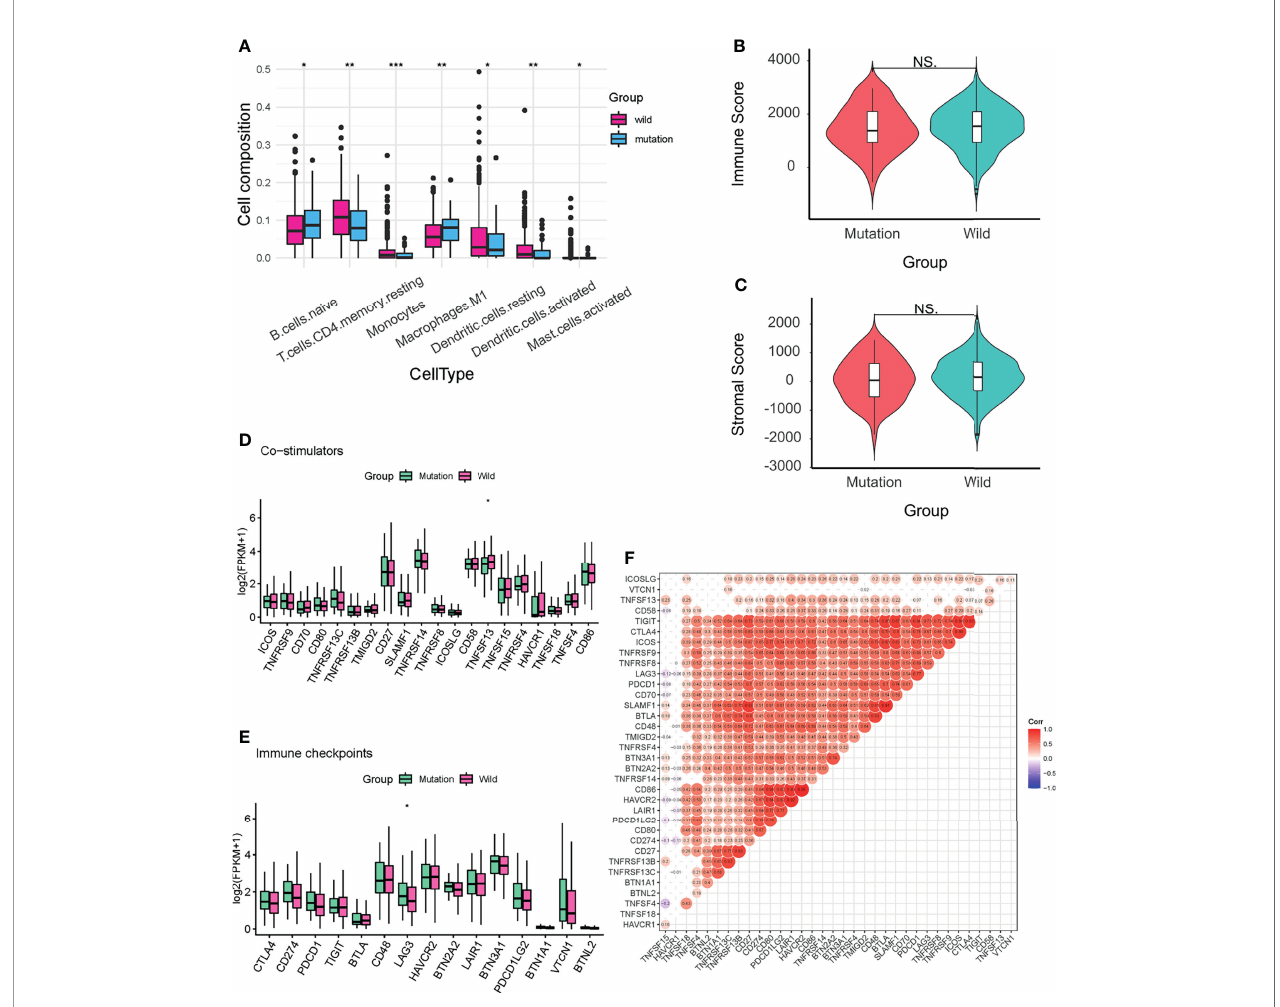
FIGURE 7 | Immune in fi ltration analysis of the two groups. (A) Seven immune cell types with signi fi cant differences between the two groups. (B, C) Stromal and immune scores of the two groups. (D, E) Expression levels of fi fteen immune checkpoints and twenty co-stimulators between the two groups. (F) Spearman correlation analysis of the immune checkpoints and co-stimulators. Labels in the circles indicated the correlation coef fi cients of the corresponding variables. Correlation coef fi cients without signi fi cant levels were hidden. NS, not signi fi cant; *P < 0.05; **P < 0.01; ***P < 0.001